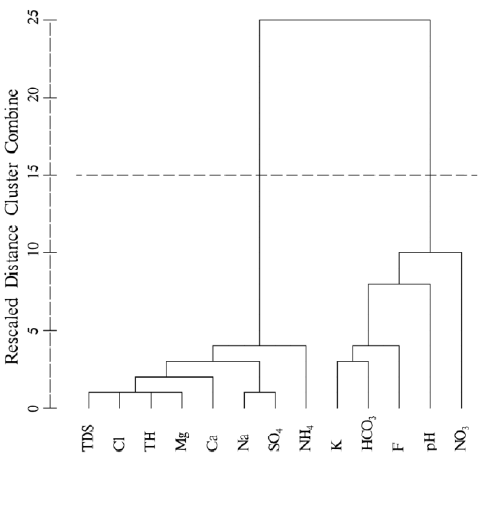
Figure 9. Dendrogram from cluster analysis (R-mode) of 13 variables for water